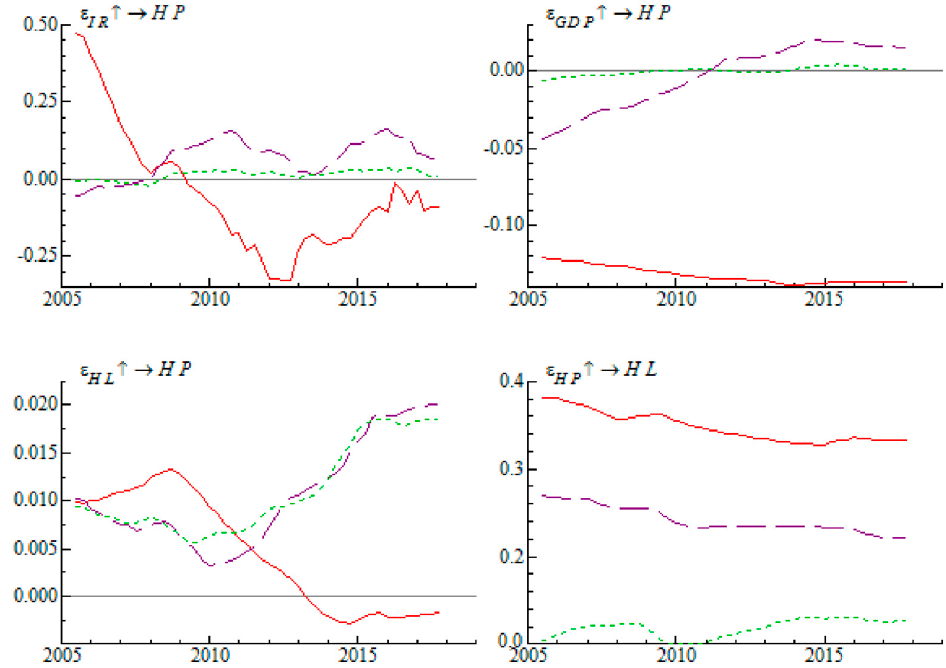
Figure 8. Impulse response for three different horizons. Notes: This shows the impulse response of the TVP-VAR model for the variable set of (IR, GDP, HL, HP); HP represents the housing price, HL represents housing loans, and IR represents the interest rate; the solid line refers to time-varying impulse responses for each quarter; the dashed line refers to half-year responses; and the dotted line refers to yearly